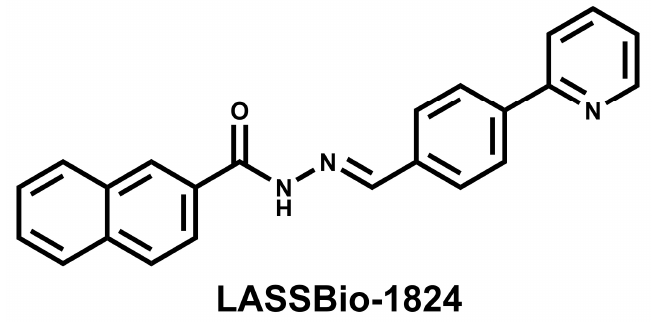
Figure 1. Molecular structure of